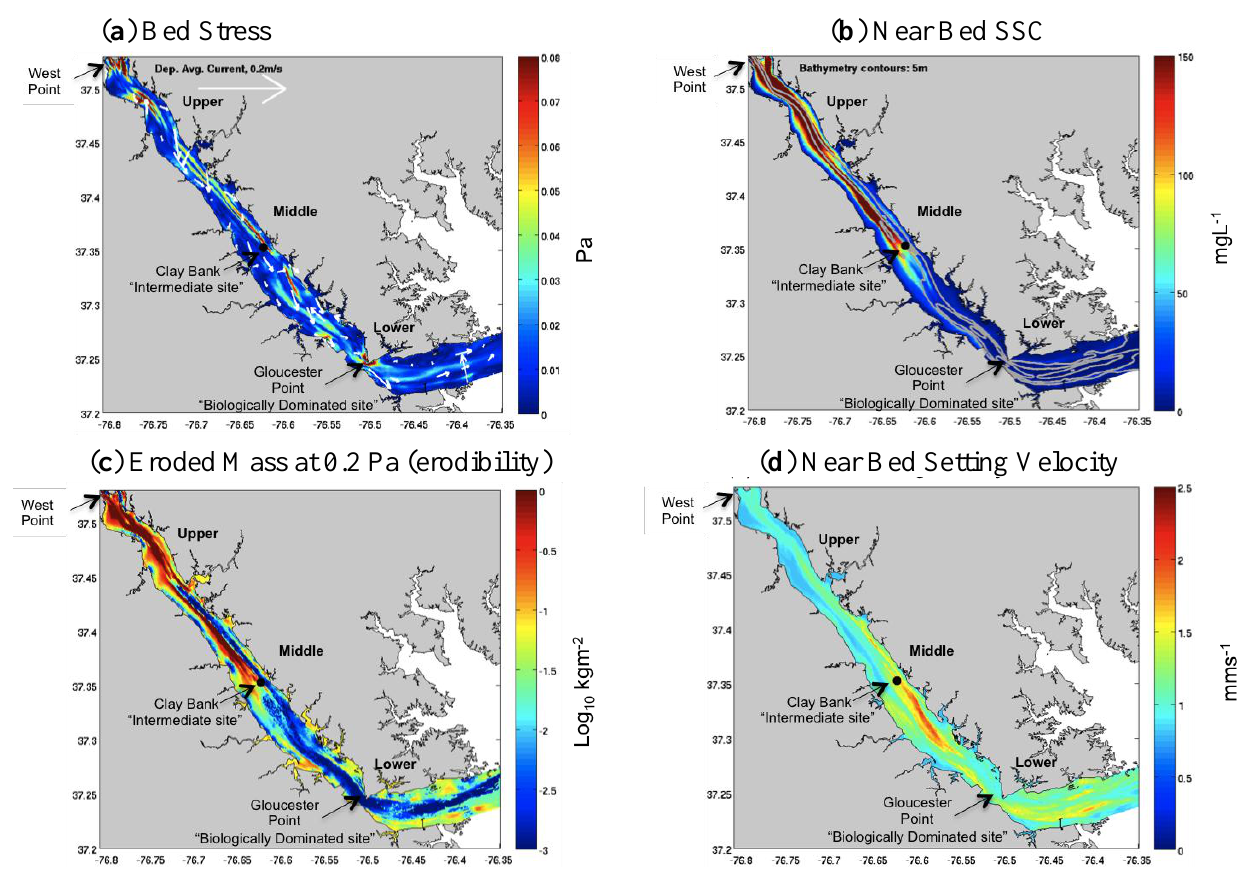
Figure 4. Daily-averaged model estimates of ( a ) bed stress, ( b ) near bed suspended sediment concentration, ( c ) mass eroded at 0.2 Pa, and ( d ) near bed settling velocity during a spring tide when high erodibility was found mid-estuary (15 July